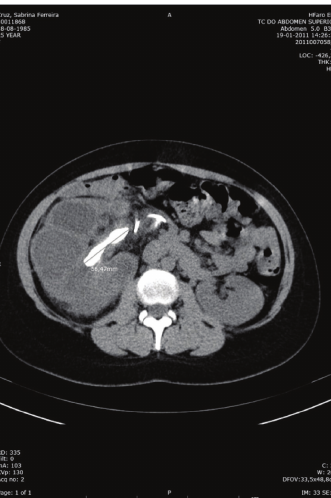
Figure 1: Abdominal pelvic CT showed an enlarged right kidney of 164mm.